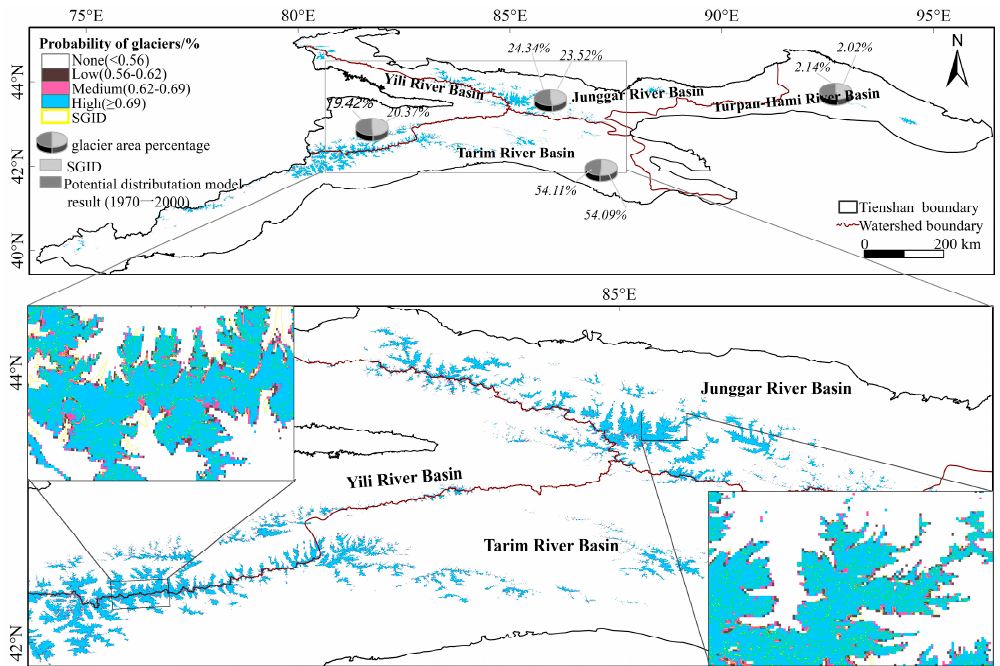
Figure 3. The potential distribution of glaciers can be showed more clearly by local enlargement in reference years (1970– 2000). SGID represents the Second Glacier Inventory of china. Glacier area percentage in the figure represents the ratio of glaciers in high suitable areas of each River Basin to the whole study regions' area.